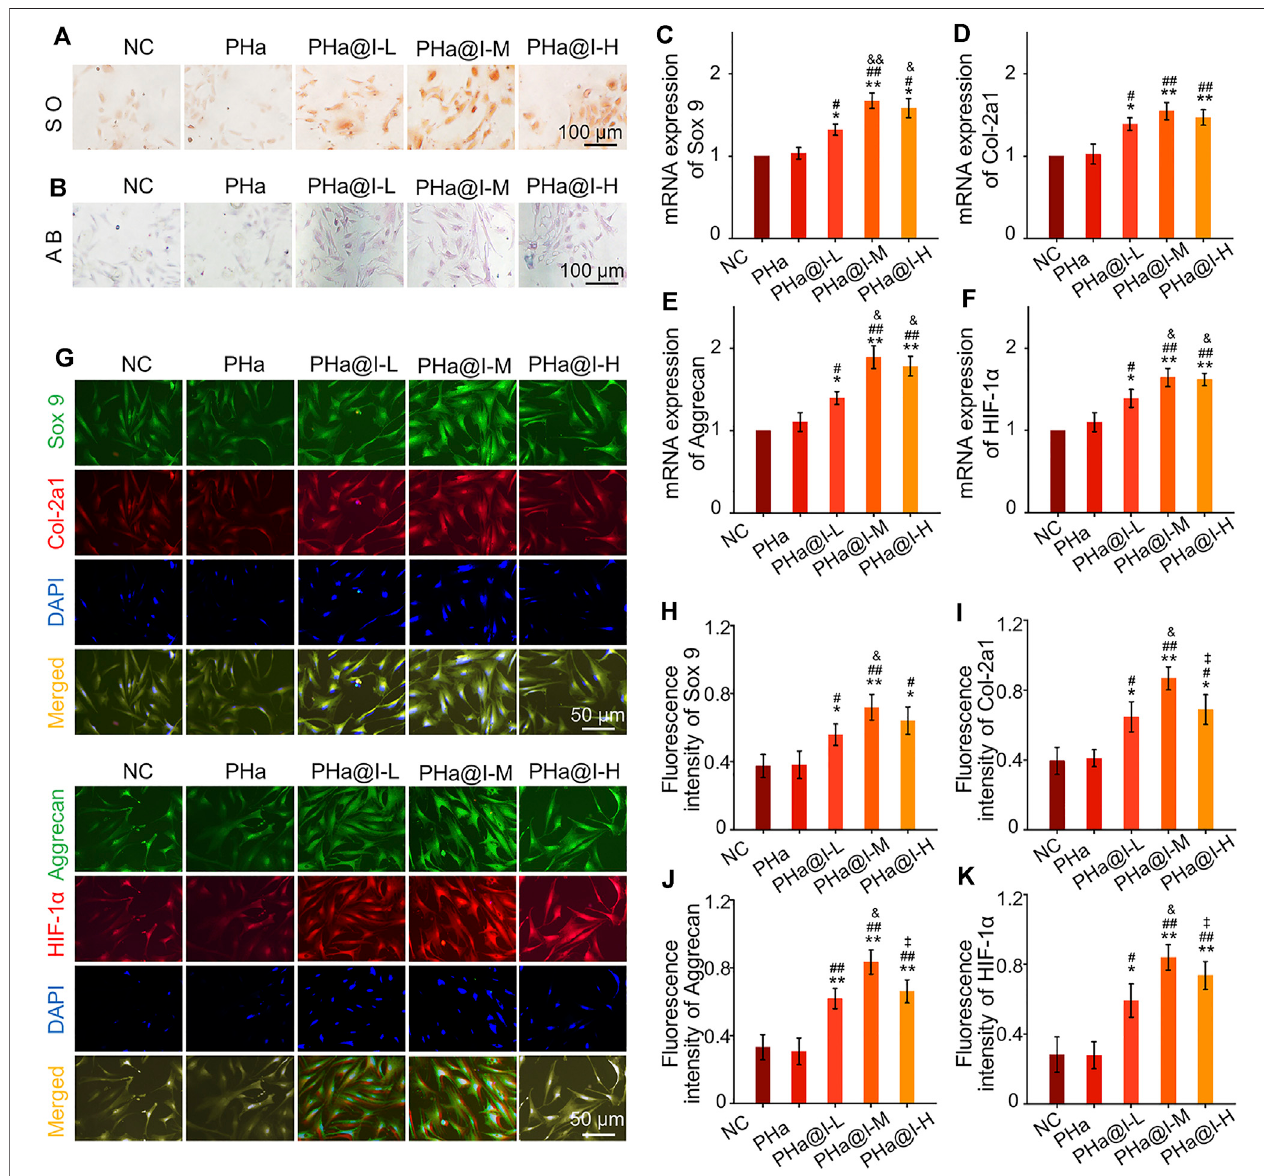
FIGURE 3 | Icariin-loaded hydrogels as 3D cell culture systems induce BMSCs chondrogenic differentiation. (A) Safranin O staining of BMSCs. (B) Alcain blue stainingofBMSCs. (C – F) RT-qPCR analysisofchondrogenic-related genes Sox 9 , Col-2a1 , Aggrecan , and HIF-1 α in BMSCsafter chondrogenic induction. (G) Double immuno fl uorescent staining of cartilage-speci fi c markers Sox 9, Col-2a1, Aggrecan, and HIF-1 α in BMSCs after chondrogenic induction. (H – K) Quantitative analysis of the immuno fl uorescence intensityofSox9,Col-2a1, Aggrecan, andHIF-1 α (* p < .05and ** p < .01compared withtheNCgroup; # p < .05and ## p < .01compared with the PHa Group; & p < .05 compared with the PHa@I-L Group; ‡ p < .05 compared with the PHa@I-M Group, n = 3).